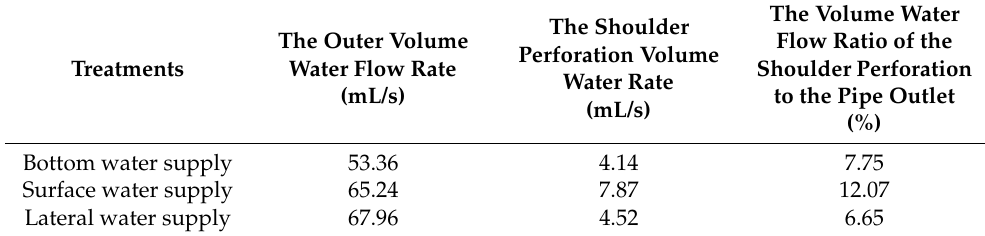
Table 5. Outer volume water flow rates of three kinds of water supply conditions.